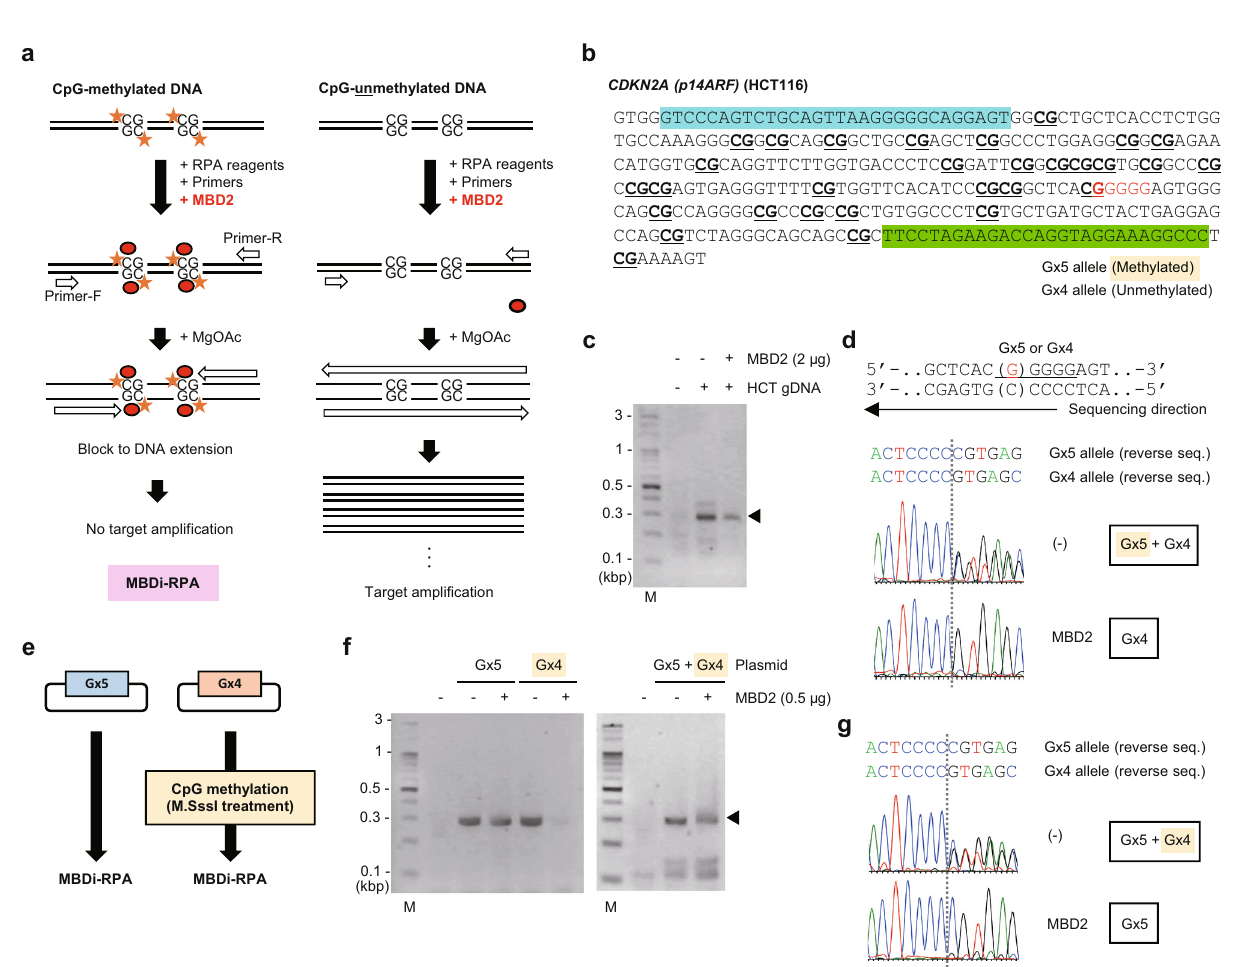
Fig. 4 Blocking RPA to discriminate CpG-methylation status. a A schematic diagram describing blocking RPA with MBD2 protein as a blocking agent (MBDi- RPA). MBD proteins bind to any methylated CpG sites in a target sequence, resulting in the suppression of ampli fi cation. MBDi-RPA can be used to discriminate CpG methylation status. b A target sequence in the human CDKN2A (p14ARF) gene in HCT116. Forward and reverse primer positions are highlighted in blue and green, respectively. c Results of MBDi-RPA. M, molecular weight marker. Ampli fi ed CDKN2A (p14ARF) is indicated by an arrowhead. d Results of DNA sequencing analysis. RPA or MBDi-RPA amplicons from c were sequenced using a reverse primer. e A schematic diagram describing MBDi-RPA of in vitro CpG- methylated plasmid DNA. The CDKN2A (p14ARF) sequences shown in b were cloned into plasmid vectors. The sequence corresponding to the Gx4 allele was subsequently methylated in vitro. f Results of MBDi-RPA from individual Gx4 and Gx5 plasmids or a plasmid mixture. g Results of DNA sequencing analysis. RPA and MBDi-RPA amplicons shown in f (plasmid mixture) were sequenced using a reverse